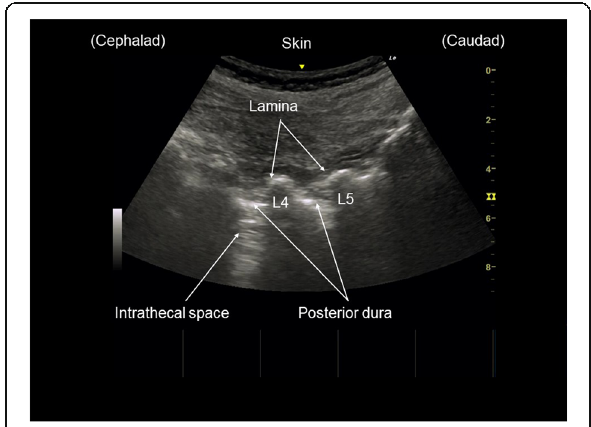
Fig. 2 An ultrasound image obtained immediately before puncture when the transducer was placed in a paramedian sagittal oblique